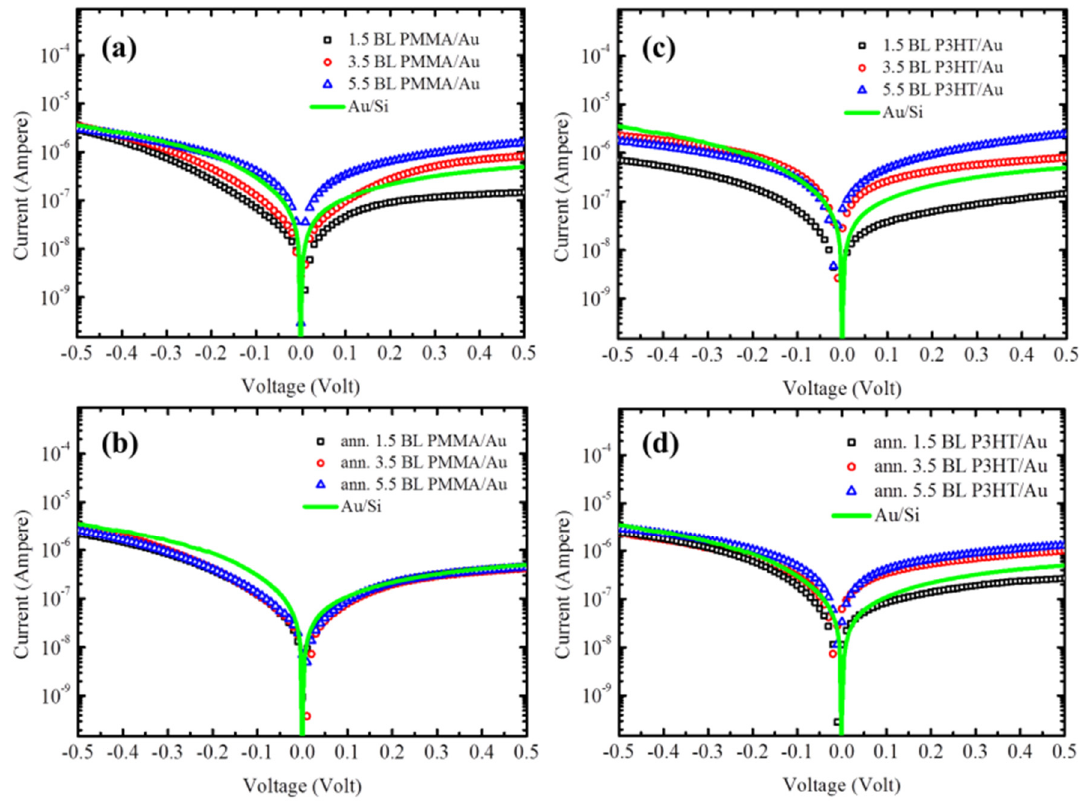
Figure 20. I - V measurements of as dep ( a ) and annealed ( b ) HyMLs PMMA/Au NPs; as deposited ( c ) and annealed ( d ) HyMLs P3HT/Au NPs. (Reproduced with permission from [80], Copyright AIP Publishing LLC